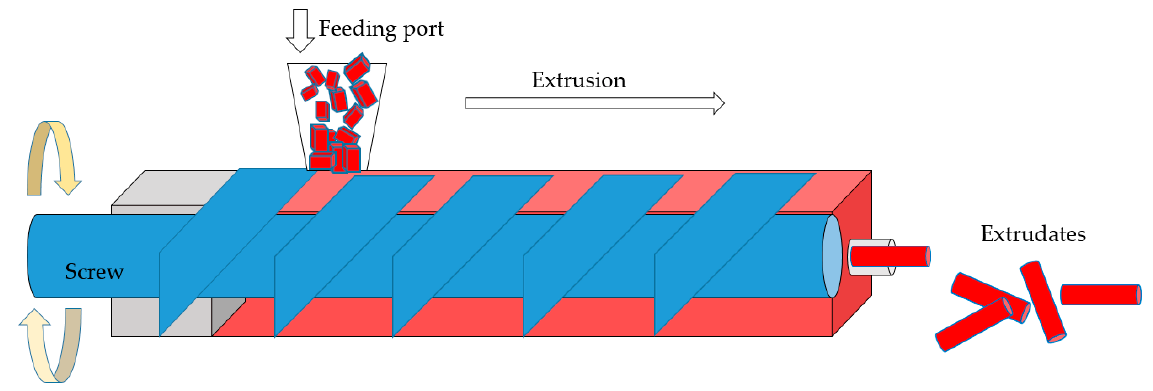
Figure 3. Schematic illustration of a single screw extrusion process and the formed extrudates.